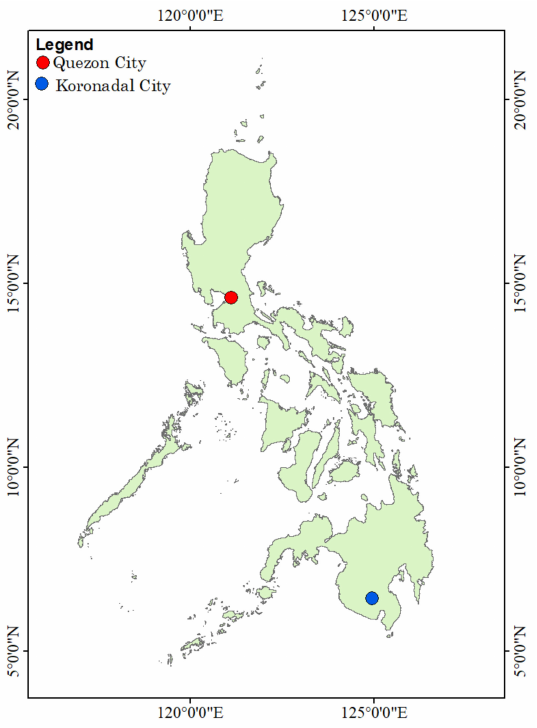
Figure 1. Satellite overpass points for MODIS data: Quezon City and Koronadal